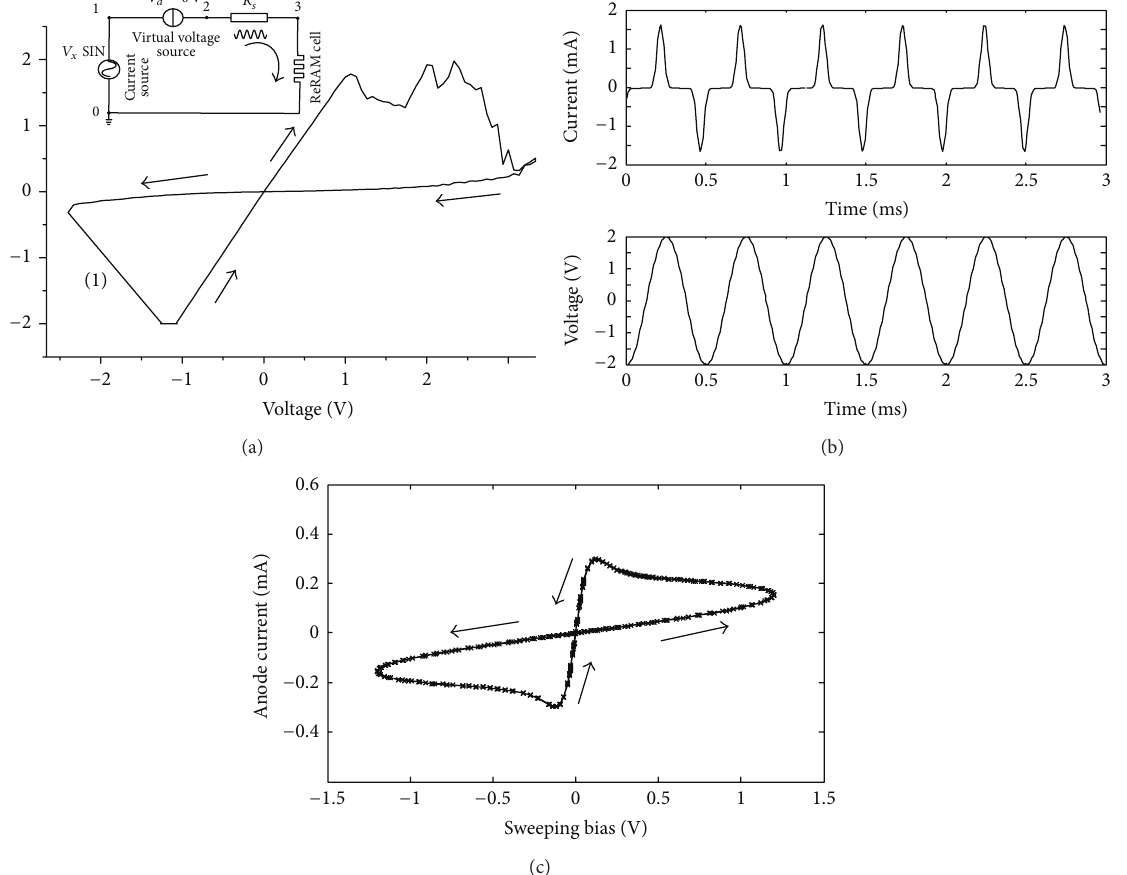
Figure 4: (a) Experimental test for ReRAM device. The test circuit contains a current source generating sinusoidal signals with frequency 2 kHz, a virtual voltage source measuring the circuit current, a rectifier resistance 𝑅 𝑠 to keep the circuit stable, and a ReRAM cell to get the I-V characteristics. (b) Continuous simulated sinusoidal sweeping bias and the corresponding output current of the ReRAM device. (c) The simulated switching loop of the ReRAM device is traversed as figure-of-eight